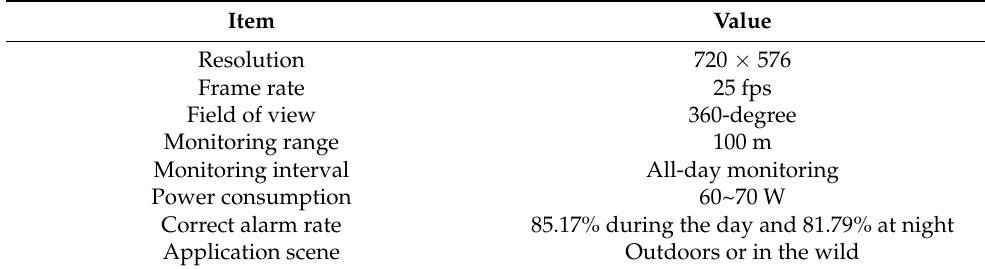
Table 2. Core indicators of the novel system.